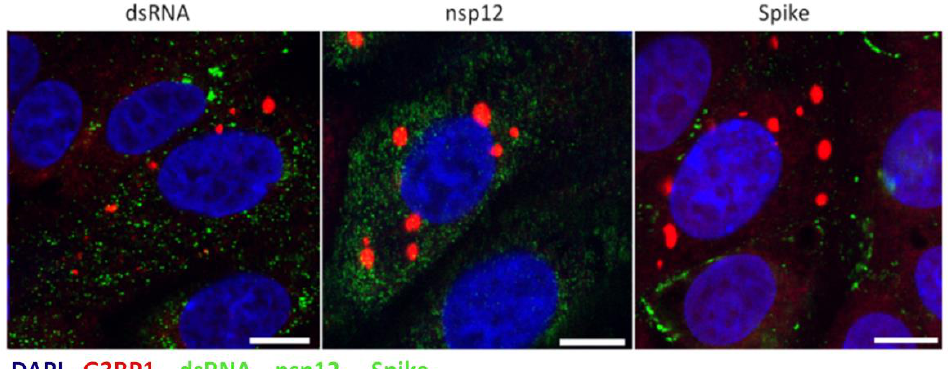
sites of virus replication.